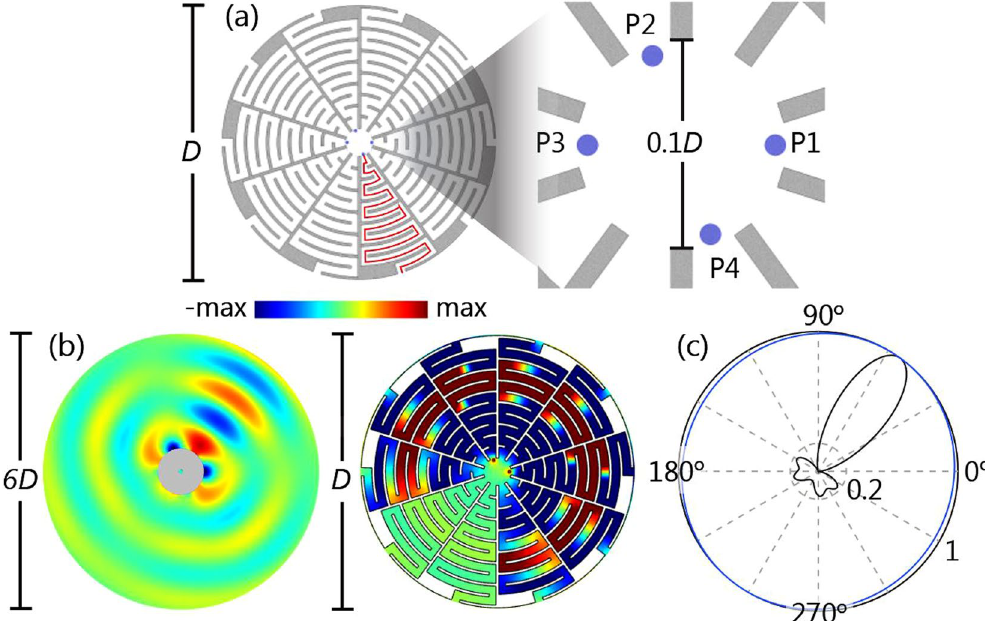
Figure 1. ( a ) A circular enclosure (left panel) made of rigid materials (gray) has coiled air-filled channels with equal sound path (red line), and the outer and inner diameters D and 0.1 D . In the interior region (right panel), there are four positions for sources (blue dots: P1, P2, P3, P4). ( b ) With the in-phase sources at P1 and P2 encompassed by the enclosure, airborne sound of wavelength 1.14 D propagates unidirectionally, shown by the simulated acoustic pressure. ( c ) The normalized far-field directivity with the enclosure (black curve) and in free space (blue curve). In the presence of the enclosure, the directivity maximum (black curve) is enhanced by 4.8 dB from the radiated sound field without the enclosure. Other parameters are the source diameter 0.01 D , sound speed in air c air = 343 m/s, and the density of air ρ air = 1.21 kg/m 3